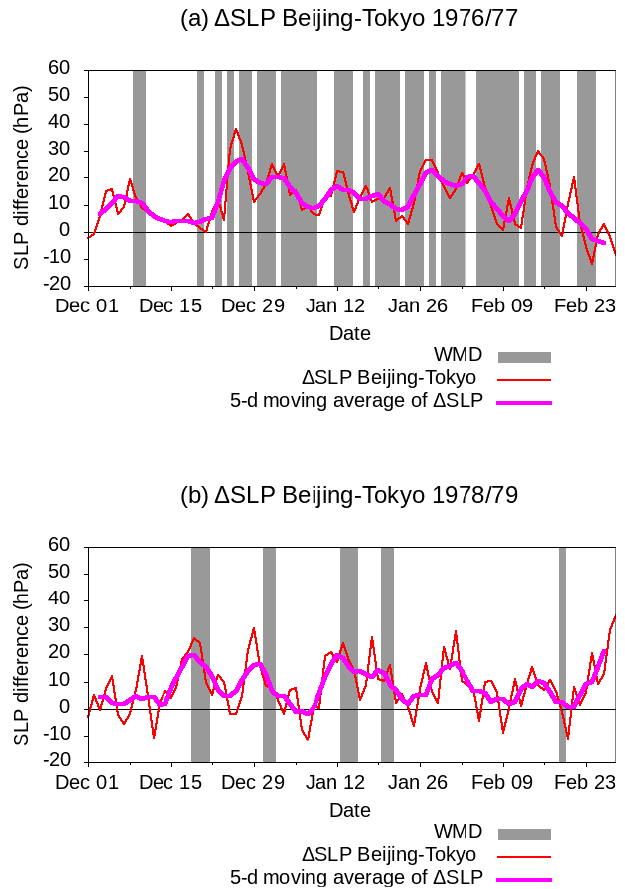
Figure 10. Temporal variations in intra-seasonal variations of east– west surface pressure differences between Nagasaki and Tokyo ( (cid:49) SLP N–T) and the dates of winter monsoon outbreak days (WMDs). (a) Cold winter year (1976/77) and (b) warm winter year